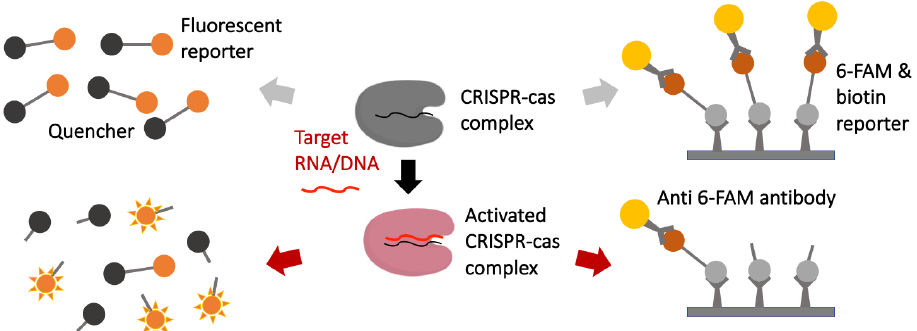
Figure 4. Cleavage-based detection utilizing the biological recognition and collateral cleavage amplification capabilities of CRISPR–Cas complexes. The signal readout can be either fluorescence- based ( left ) or a lateral flow readout of molecular weight, often with reporter complexes, such as FAM–biotin ( right